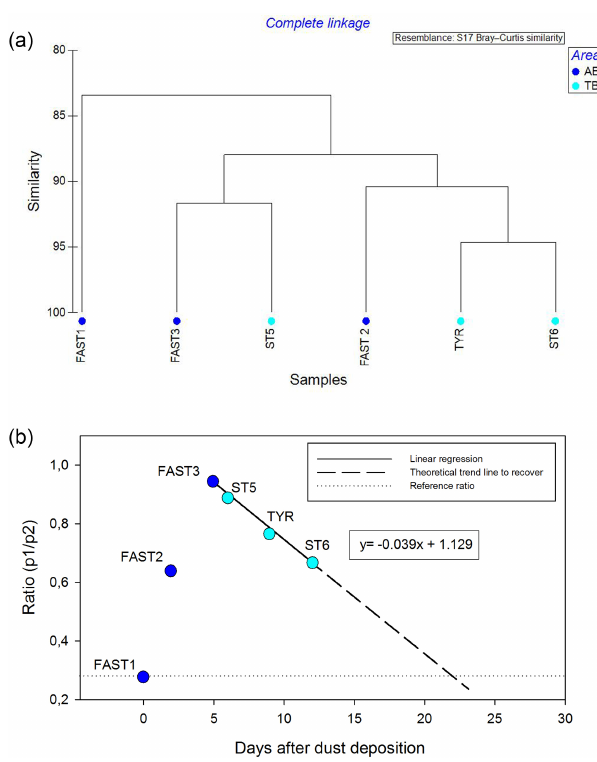
Figure 11. Cluster analysis on rank frequency diagrams (a) and changing trends in the p 1 /p 2 ratio (b) on the stations impacted by wet dust